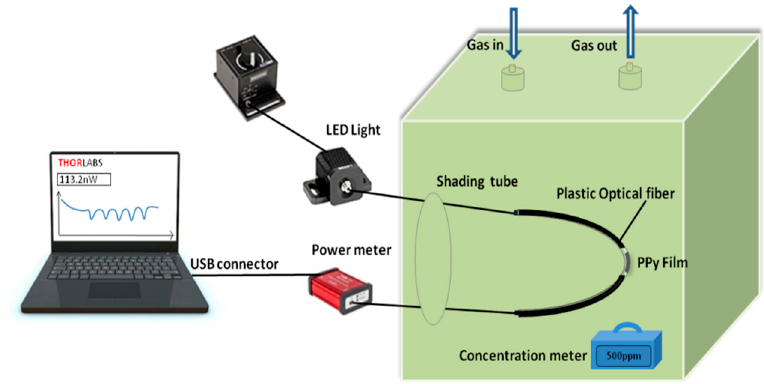
Figure 3. The experimental setup of the POF-PPy sensor.